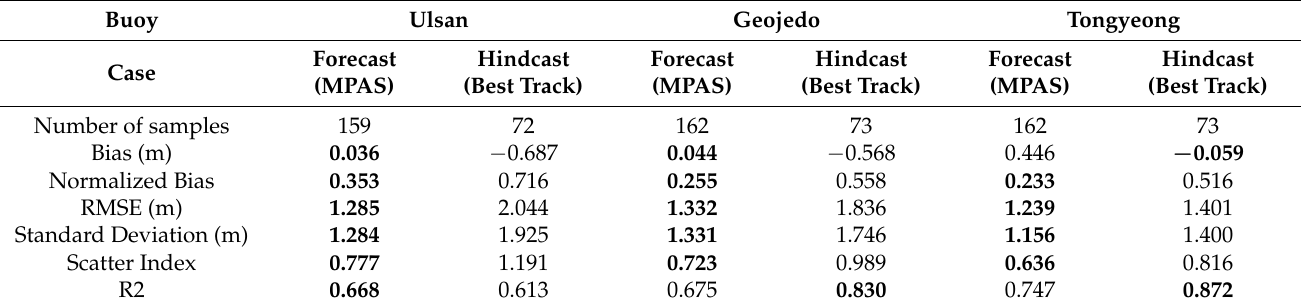
Table 5. Statistics on significant wave heights from the MPAS forecast and the hindcast experiments for typhoon Maysak. Here, better scores are indicated in bold.